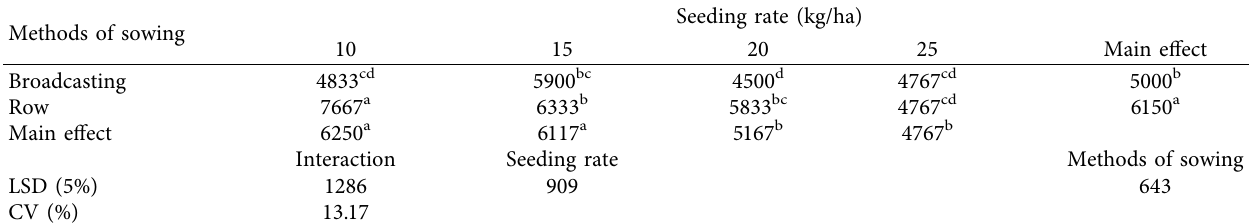
Table 4: Interaction and main effect of seeding rate and methods of sowing on biological yield teff (kg/ha). Methods of sowing